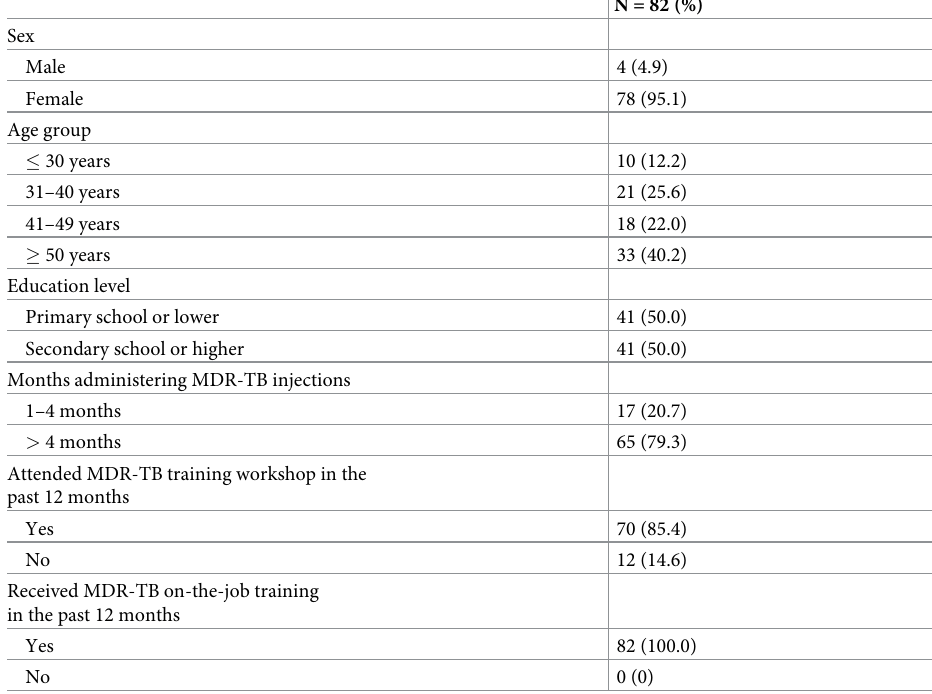
Table 1. Socio-demographic